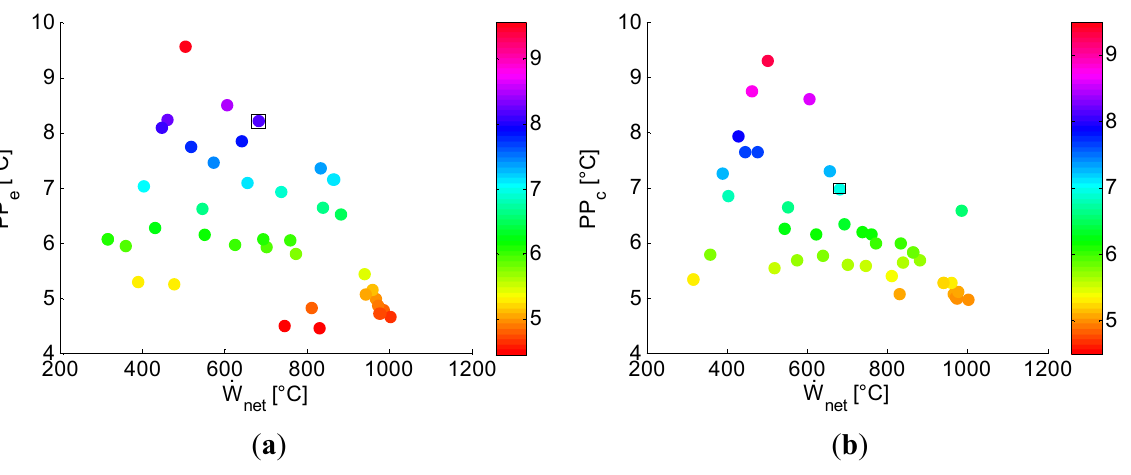
and ( b ) (cid:1842)(cid:1842) in function of SIC for the TCORC. (cid:3032) (cid:3030)